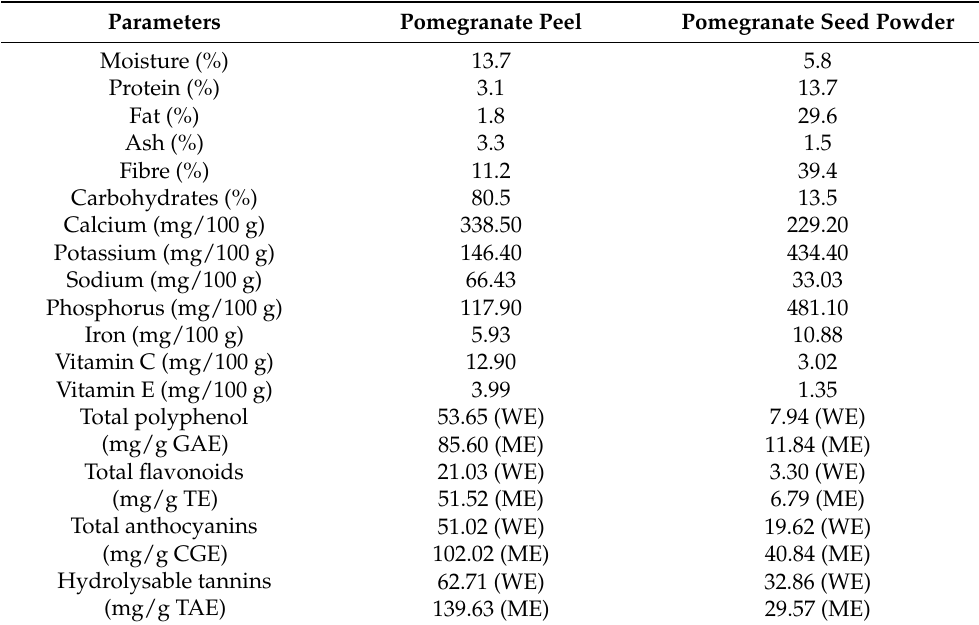
Table 1. Proximate composition, major micronutrients, vitamins, and polyphenolic content of pomegranate peel and seed powder. Parameters Pomegranate Peel Pomegranate Seed Powder Moisture